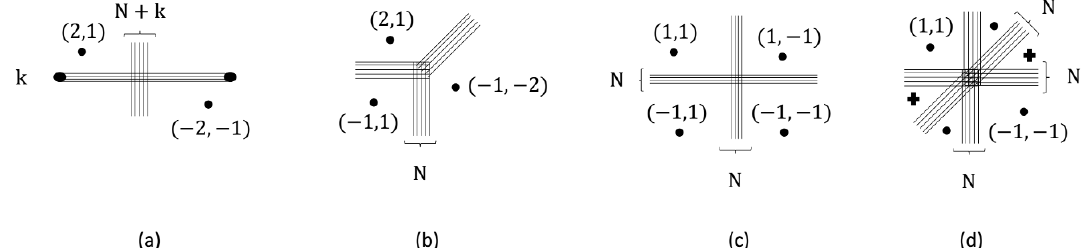
Figure 10 . The brane webs describing the e(cid:11)ective 5 d theory that results from the compacti(cid:12)cation of the 6 d SCFTs introduced in this subsection. Speci(cid:12)cally, (a) is for the Z 2 cases in (cid:12)gure 3, where k = 2 l for (a) and k = 2 l + 1 for (b), and N is as de(cid:12)ned in that section. (b) is for the Z 3 cases in (cid:12)gure 5, where N is as de(cid:12)ned in that section. (c) and (d) are for the Z 4 and Z 6 cases, respectively, where again N is as de(cid:12)ned there. Here we use black dots for 7-branes, where we have written their ( p; q )-charges next to them. If no charges are written, then it is a D7-brane. We also use black + for (0 ; 1) 7-branes. The con(cid:12)gurations are drawn such that they show the discrete symmetry permuting the (cid:13)avor symmetry, here manifested by a rotation in the plane of the web accompanied with the appropriate SL(2 ; Z )